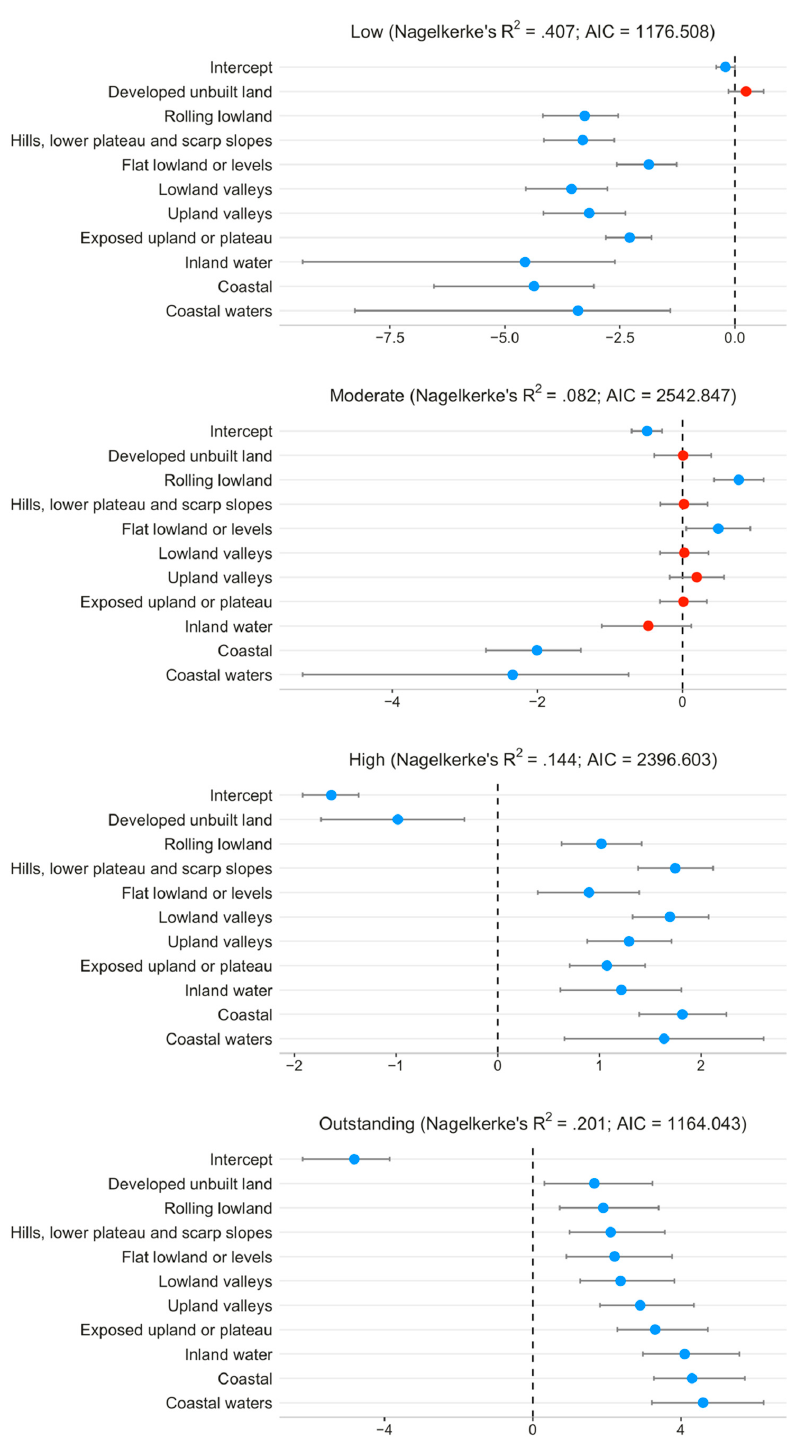
Figure 3. The effect of various landforms on different levels of scenic quality were graphed on log scales, allowing a visual comparison of the magnitudes of confidence intervals and standard errors. Dots represent unstandardised point estimates (that is, log odds ratios) derived from the binary logistic linear regressions for the landform typologies concerning different levels of scenic quality evaluated by experts where the referent class was “built land.” The vertical dash line represents the line of null effect, denoting there is no difference from the baseline. The goodness-of-fit of the model is indicated by Nagelkerke’s R 2 and AIC measures. The error bar denotes 95% confidence intervals, indicating the uncertainty of the estimate. While the confidence interval crosses the line of null effect, the point estimate is statistically significant, denoted by dot colour (blue: p < 0.05; red: p ≥